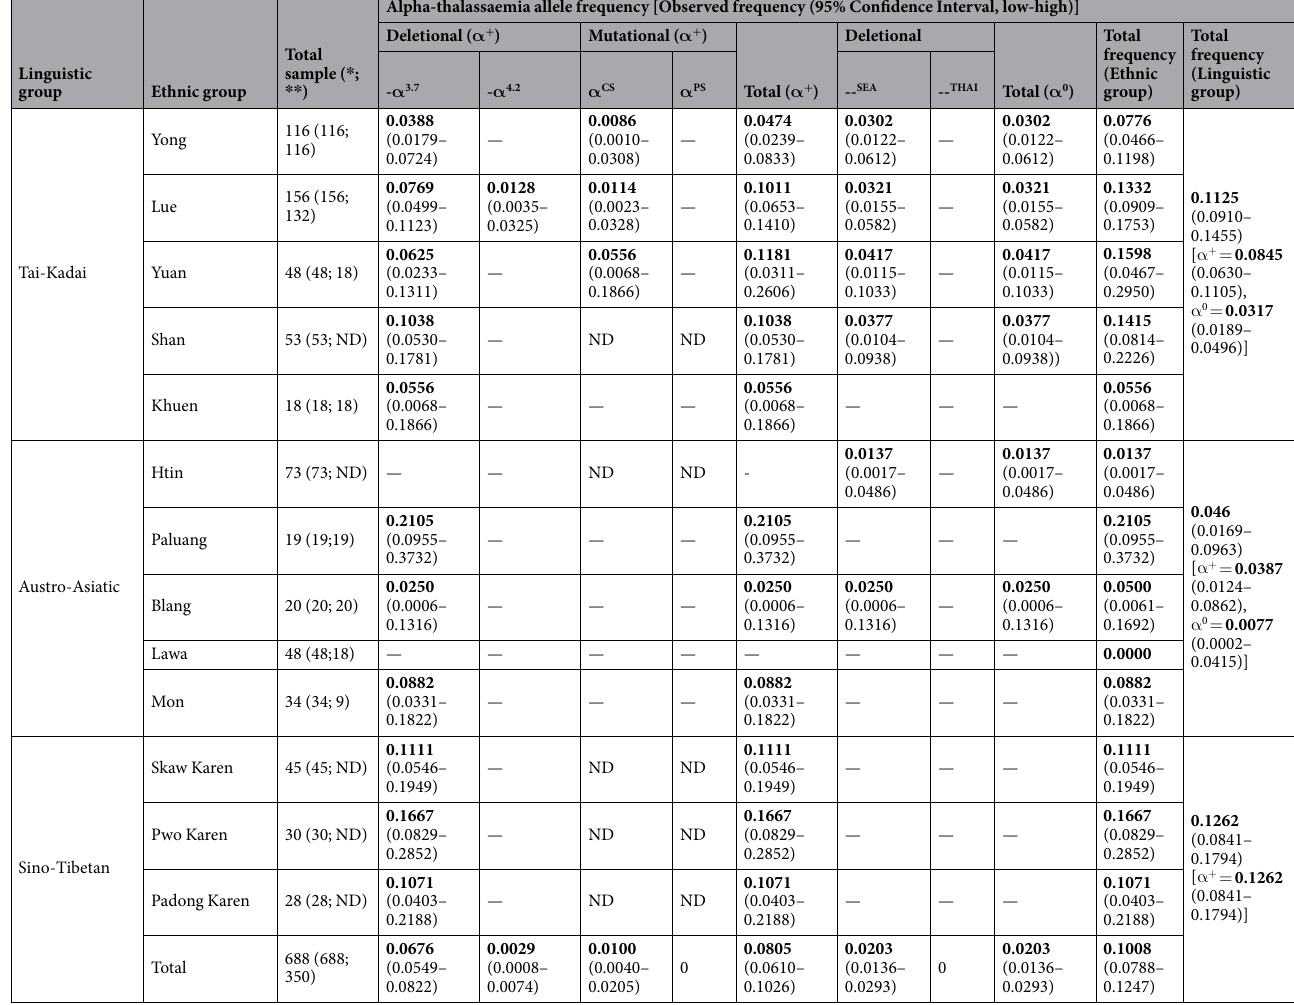
Table 2. The allele frequency of α -thalassaemia in the population residing in northern Thailand. ND = Unverified point-mutational alpha-globin gene anomalies ( α CS , α PS ) by a dot-blot hybridization method. * The number of sample enrolled in this study was subjected to four deletional alpha-thalassaemia screening (- α 3.7 , - α 4.2 , -- SEA and -- THAI ). ** The number of sample enrolled in this study was subjected to four deletional (- α 3.7 , - α 4.2 , -- SEA and -- THAI ) and two mutational ( α CS , α PS ) alpha-thalassaemia